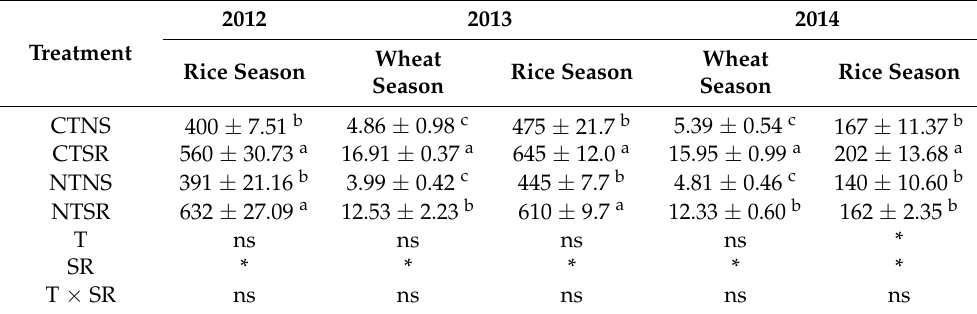
Table 2. Seasonal CH 4 emissions (kg hm − 2 ) under different tillage and straw return practices (2012– 2014) (has been published by Guo et al.